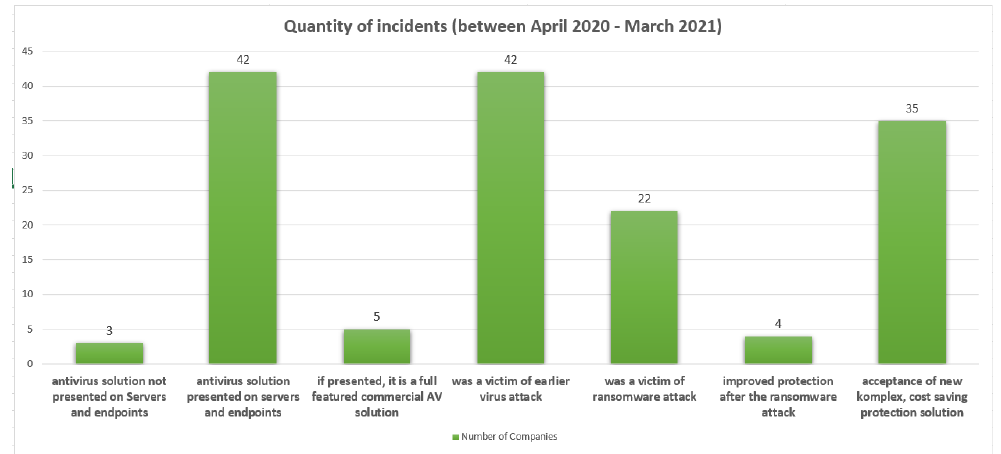
Figure 9. Virus and ransomware attacks in the year preceding the